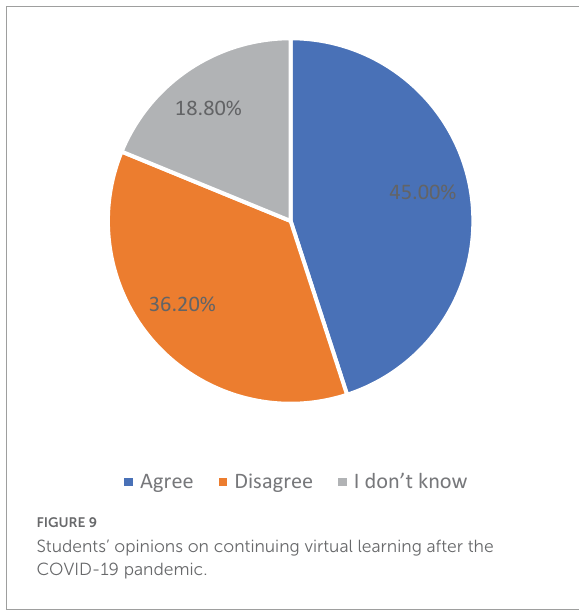
FIGURE10 Students’ opinions on applying virtual skills to learning